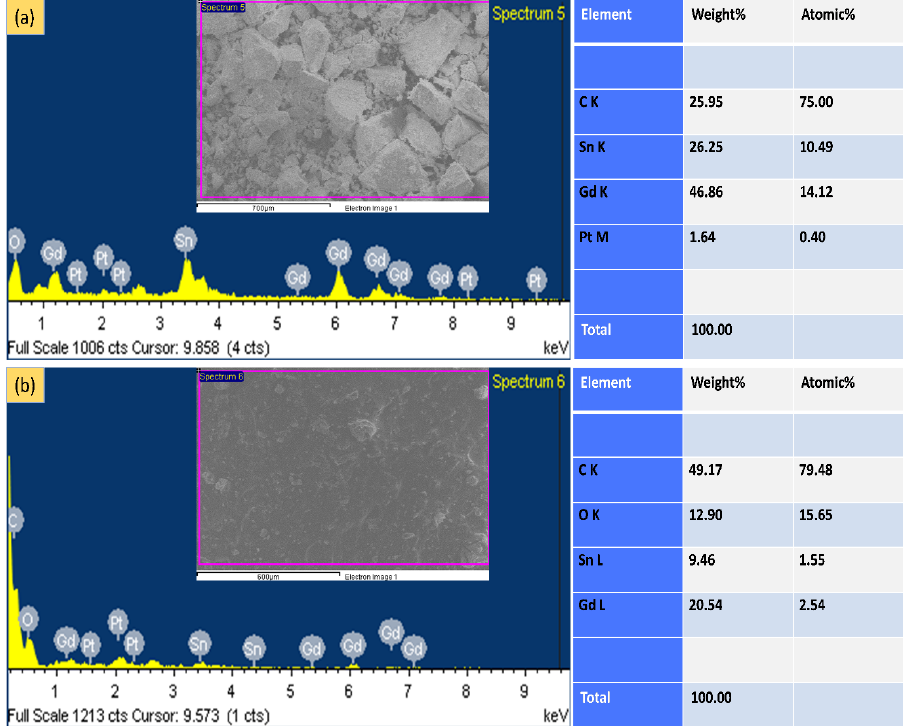
Figure 3. EDX spectra of Sn-Gd2O3 nanomaterial ( a ) and Sn-Gd2O3@GH nanocomposite ( b ).